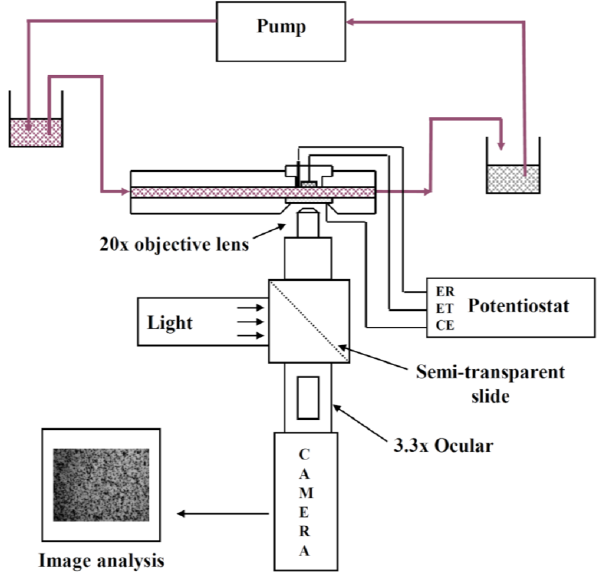
Figure 1. Electrophoretic deposition (EPD) laminar flow cell with the optical and image analysis